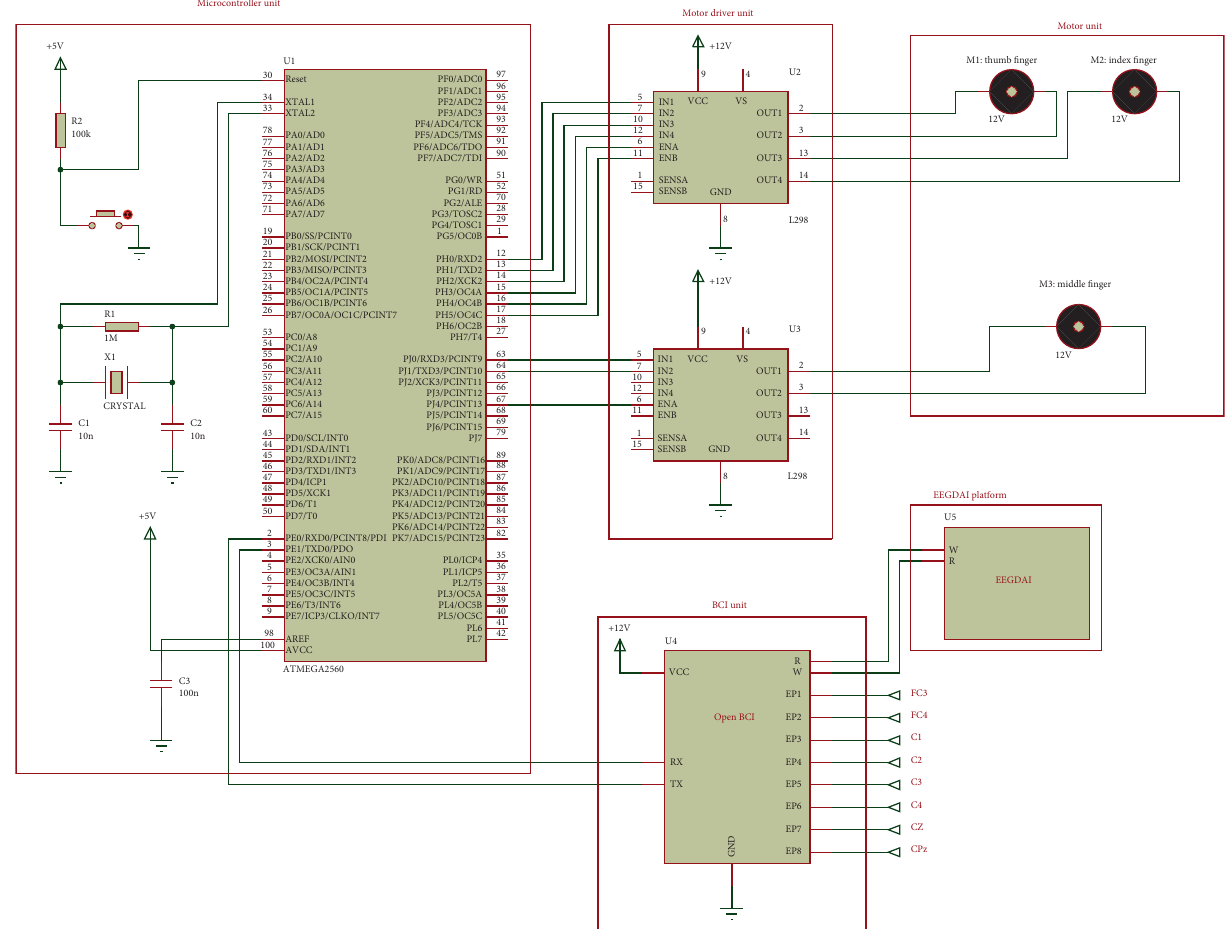
Figure 9: The hardware schematic diagram of the proposed system. Table 6: Activity descriptions of the